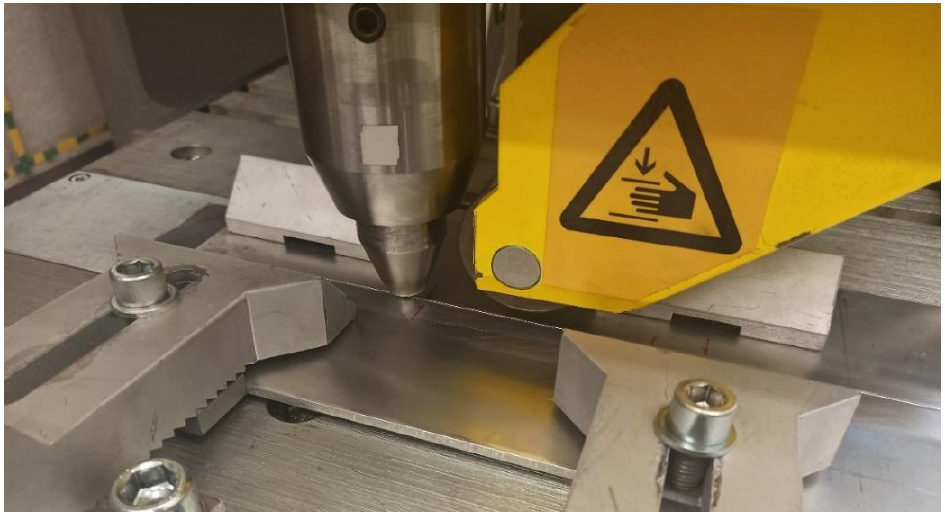
Figure 1. Welding system used in this study.